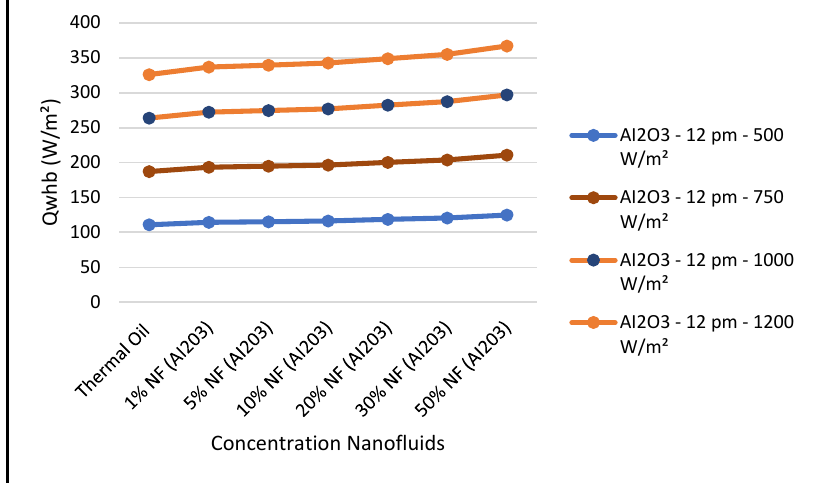
Figure 21. Thermal energy stored in thermal tank at di ff erent concentrations of Al 2 O 3.